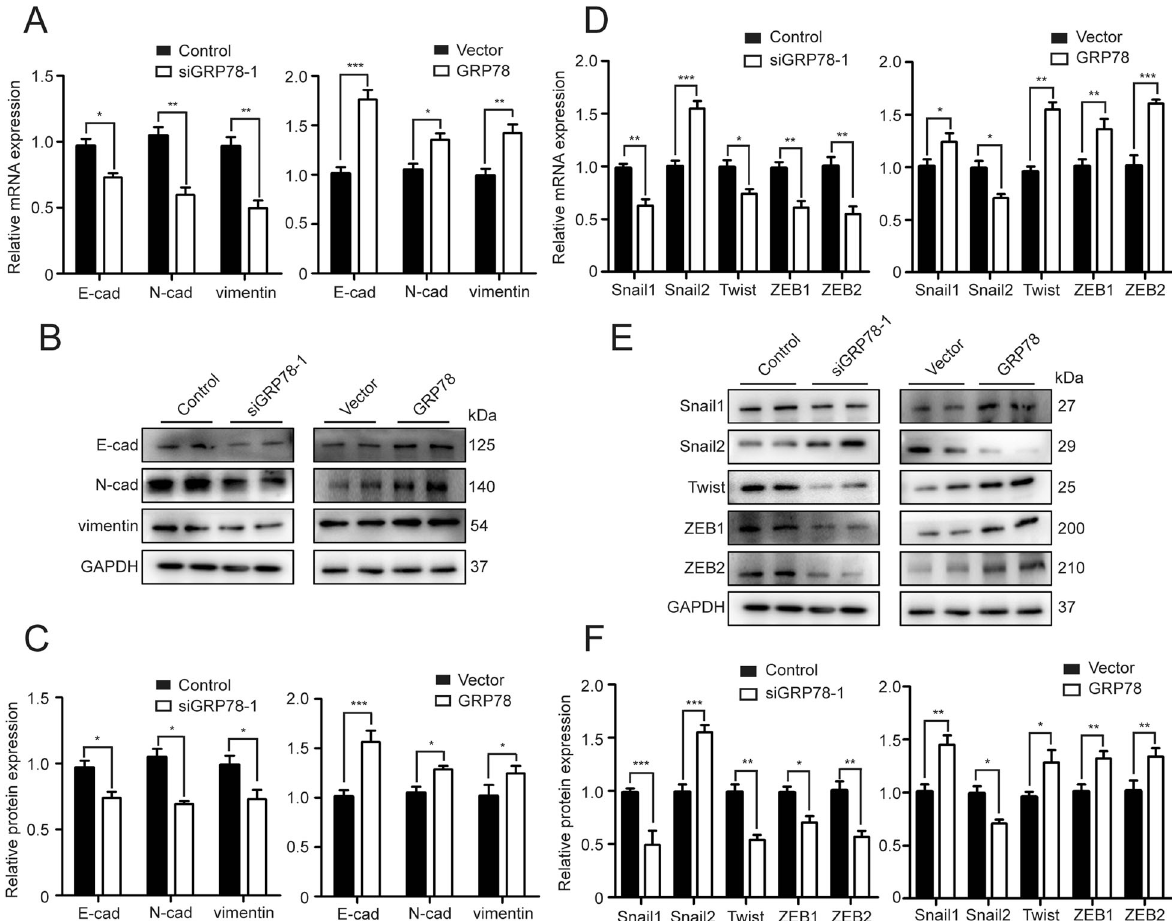
Fig. 6 GRP78 regulates multiple EMT markers in BPH-1 cells. A , B The mRNA and protein expression of E-cad, N-cad and vimentin in GRP78- silenced or GRP78-overexpressed BPH-1 cells. C Relative densitometric quanti fi cation of three EMT markers. D , E The mRNA and protein expression of several EMT-TFs (Snail1, Snail2, Twist, ZEB1 and ZEB2) in BPH-1 cells. F Relative densitometric quanti fi cation of these EMT-TFs. In all fi gures, GAPDH is used as loading control. * p < 0.05; ** p < 0.01; *** p <